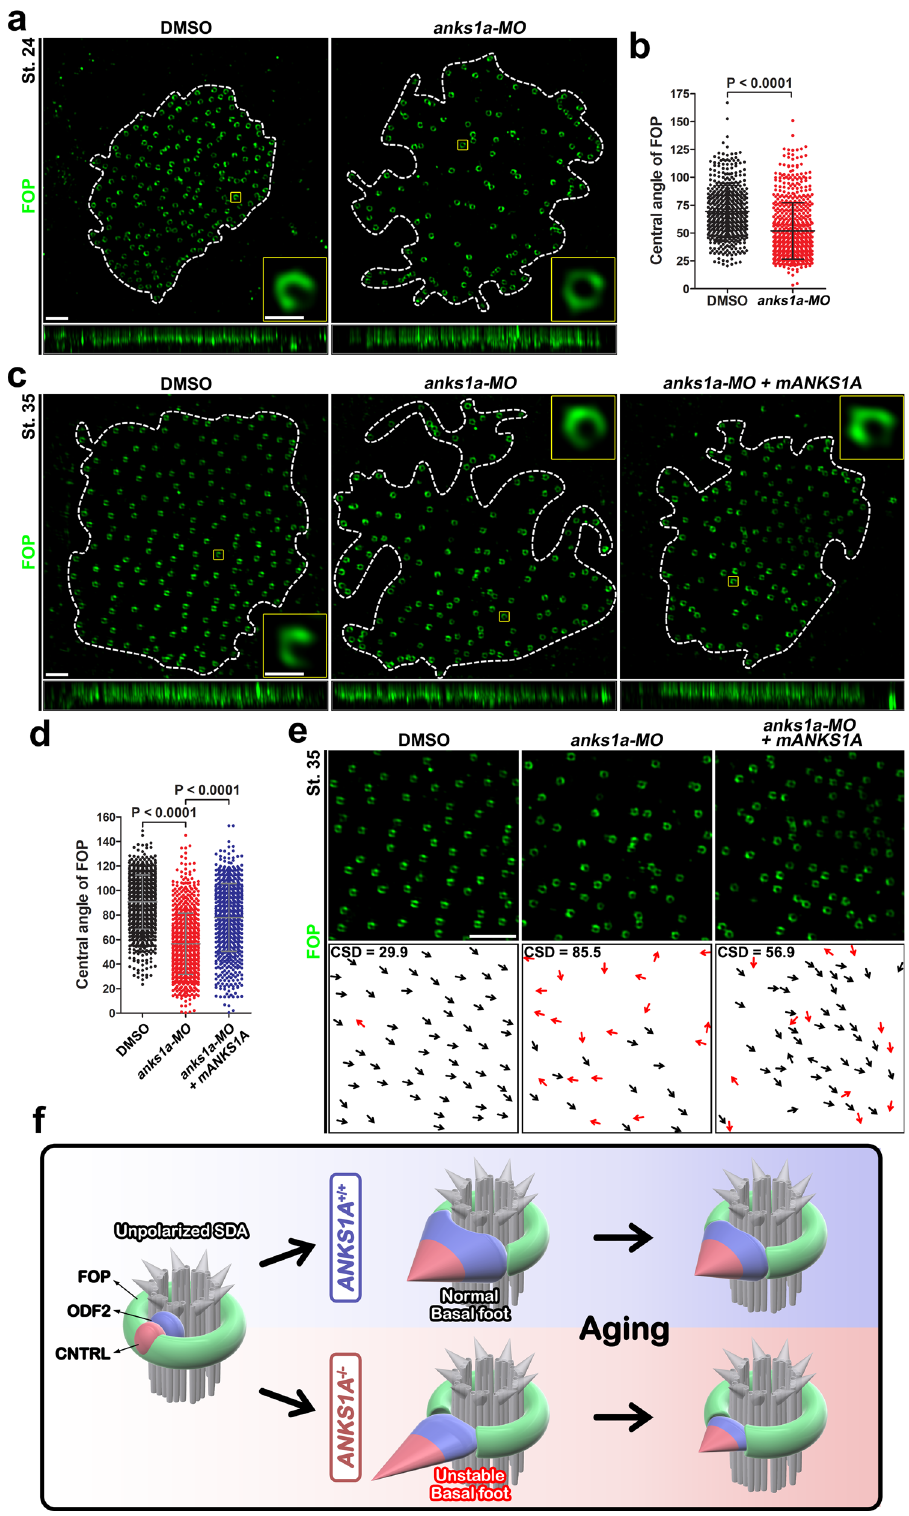
Fig. 2g with Fig. 6c). Importantly, ANKS1A de fi ciency aggravates the natural degeneration of SDAs in aged mice leading to a dis- integration of the FOP-positive basal rim and the intercalation of BF proteins into the resulting unpolarized ring structure. The deteriorating SDAs are likely to have BBs surrounded by a more unstable and fragile cytoskeletal network, ultimately leading to detachment of BBs and motile cilia through the long-term